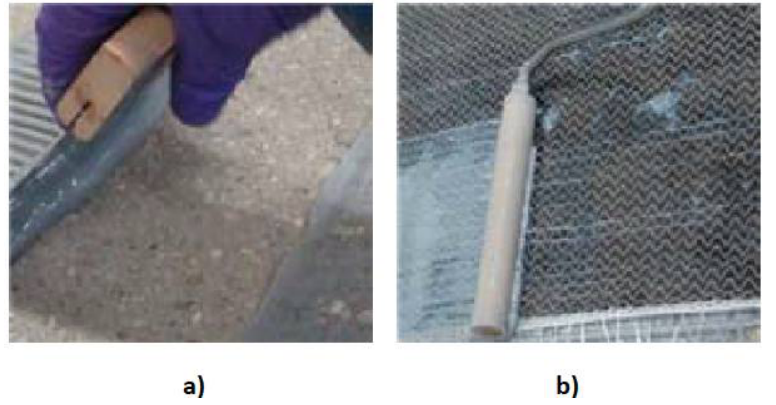
Figure 7 . Stages in the dry lay-up process: ( a ) reinforcing the concrete substrate and ( b ) applying the FRP reinforcement to the concrete substrate, adapted from [27].